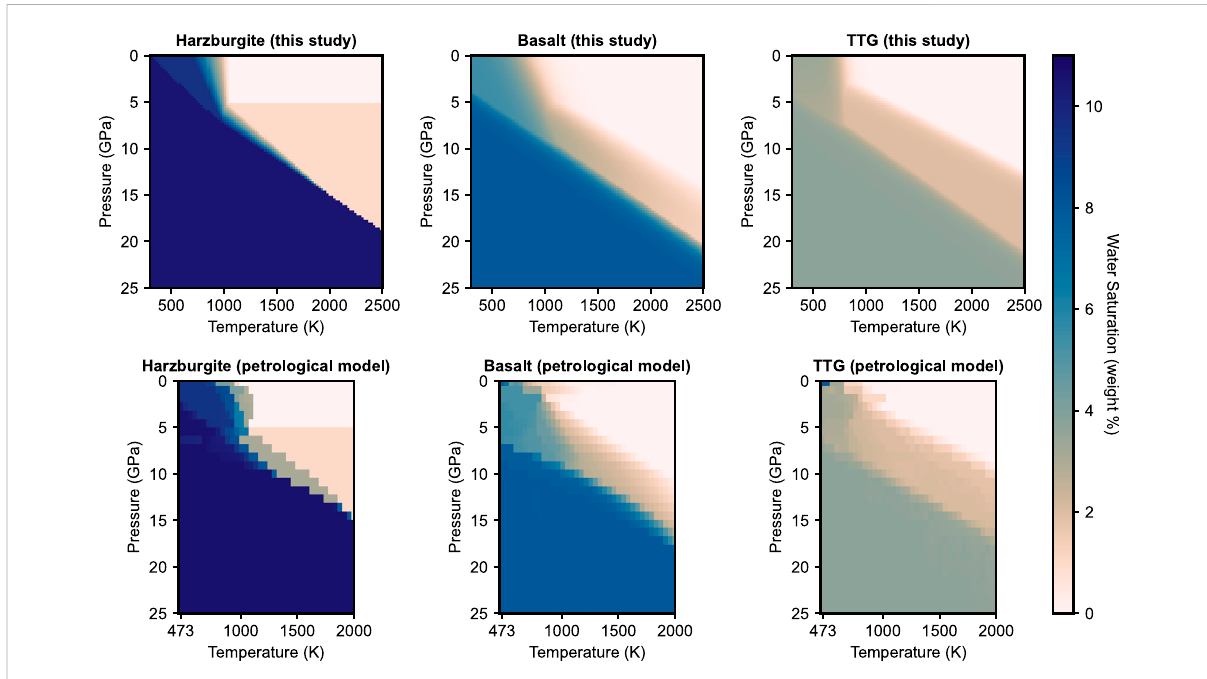
FIGURE 1 Water solubility maps. Top row: analytical functions used in our models. Bottom row: look-up tables obtained with Perplex (Connolly,